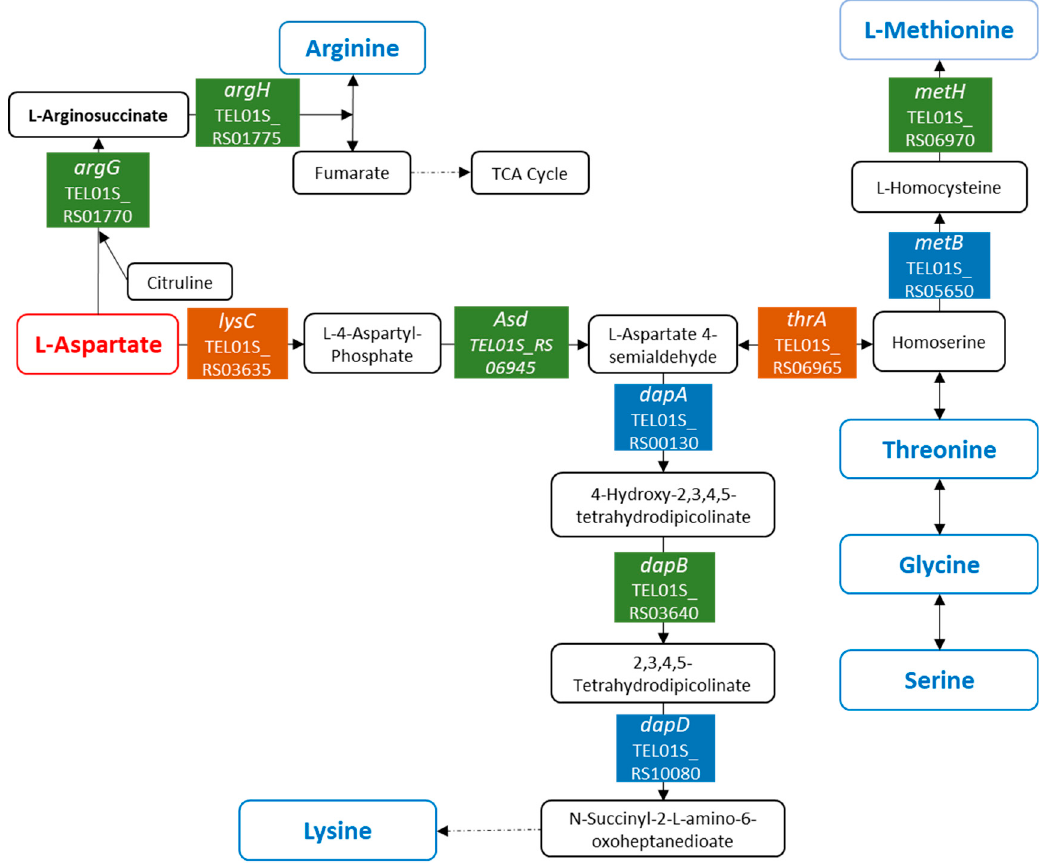
Figure 4. Schematic illustrating the amino acid metabolism pathways highlighted from the DEG. Colored boxes indicate the enzymes for which the genes are differentially expressed: blue means genes were over-expressed at 30 MPa, green means genes were over-expressed at 30 and 40 MPa, and orange means genes were over-expressed at 20, 30, and 40